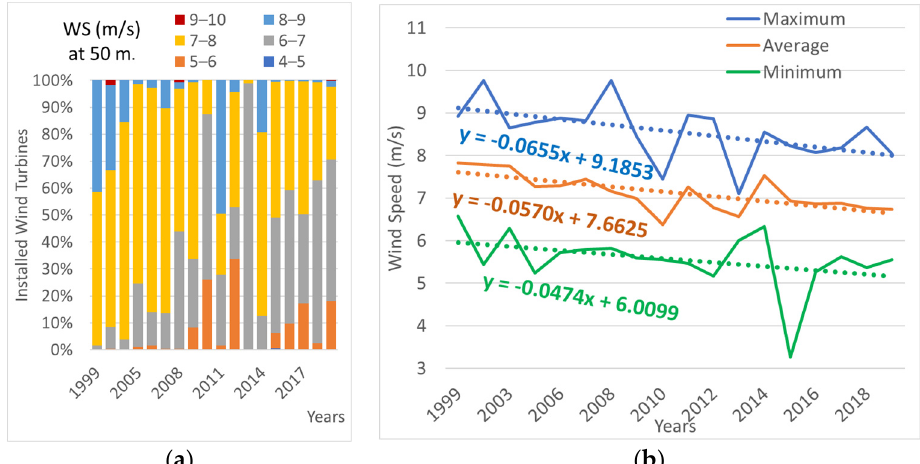
Figure 10. Trends of new wind turbines in Texas per wind speed area (m/s) at a height of 50 m: ( a ) percentage installed wind turbines and ( b ) as trend of the change in wind speed area.